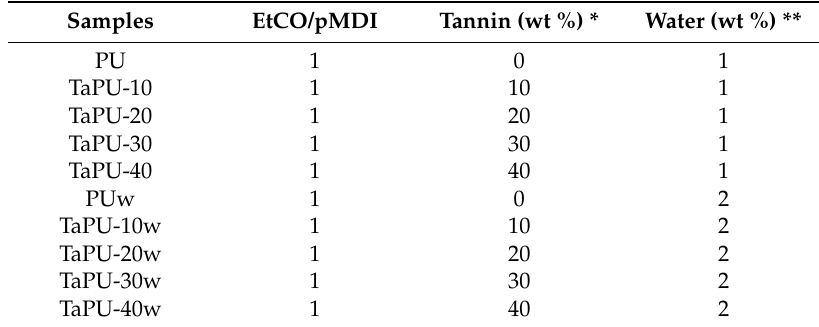
Table 1. PU and TaPU foam